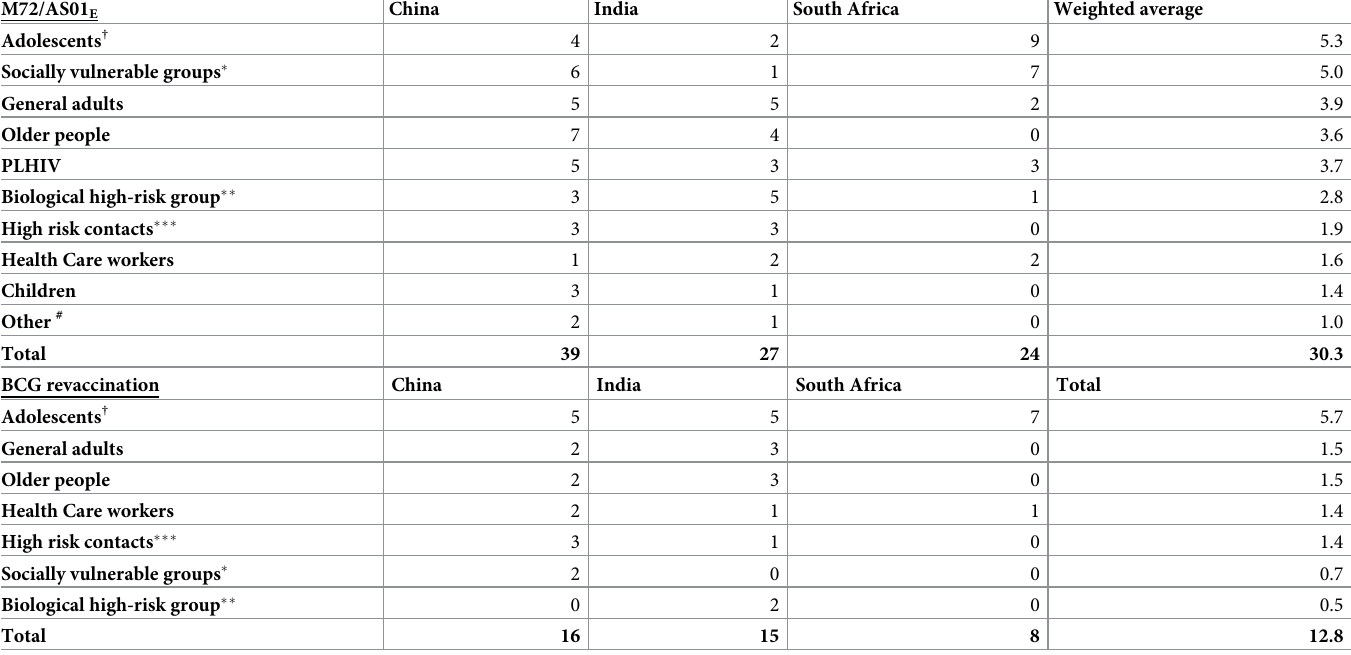
Table 1. Number of times scenarios/strategies targeting specific groups with M72/AS01 E and BCG revaccination-like candidates, were mentioned by interviewees, for China, India, and South